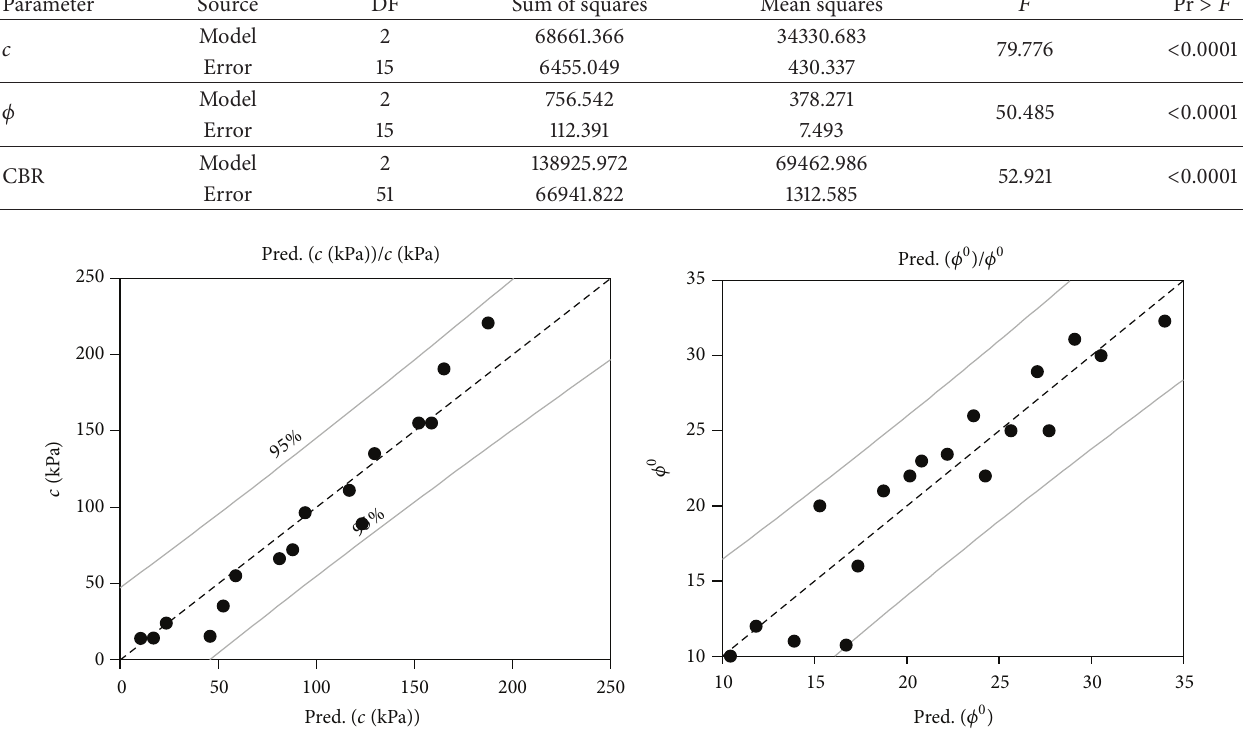
Figure 18: Measured and predicted shear strength ( 𝑐 , 𝜙 ) values derived from (2).